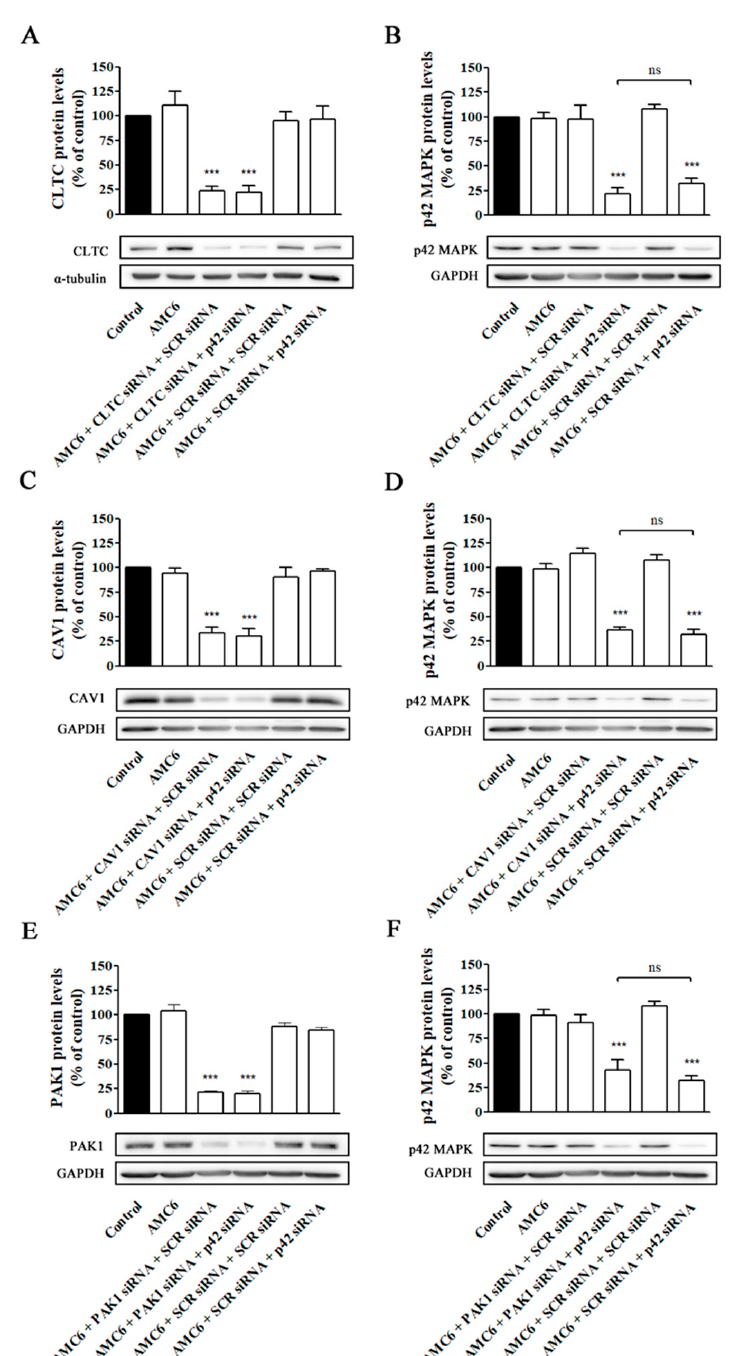
Figure 9. E ff ect of selective knockdown of CLTC ( A , B ), CAV1 ( C , D ), and PAK1( E , F ) on AMC6-mediated transfection e ffi ciency. T98G cells were treated for 48 h with either vehicle (control), AMC6 (1 µ M) or nanoplexes formed by AMC6 (1 uM) / specific siRNA (50 nM) targeting CLTC ( A ), CAV1 ( C ) and PAK1 ( E ). Then, the culture medium was replaced by one containing nanoplexes formed by AMC6 and 50 nM of either SCR siRNA or anti-p42- mitogen-activated protein kinase (p42 MAPK) and cells were incubated for additional 48 h. CLTC ( A ), CAV1 ( C ), and PAK1 ( E ) protein levels were determined respect to control values. In the experiments shown in panels B, D, and F, the cells received the same treatments, but p42-MAPK levels were determined instead. Western blot images shown representative experiments for each protocol. Data are expressed as mean ± SEM of 3 or 4 individual experiments for each group. *** p < 0.001 as compared to control; ns, statistically